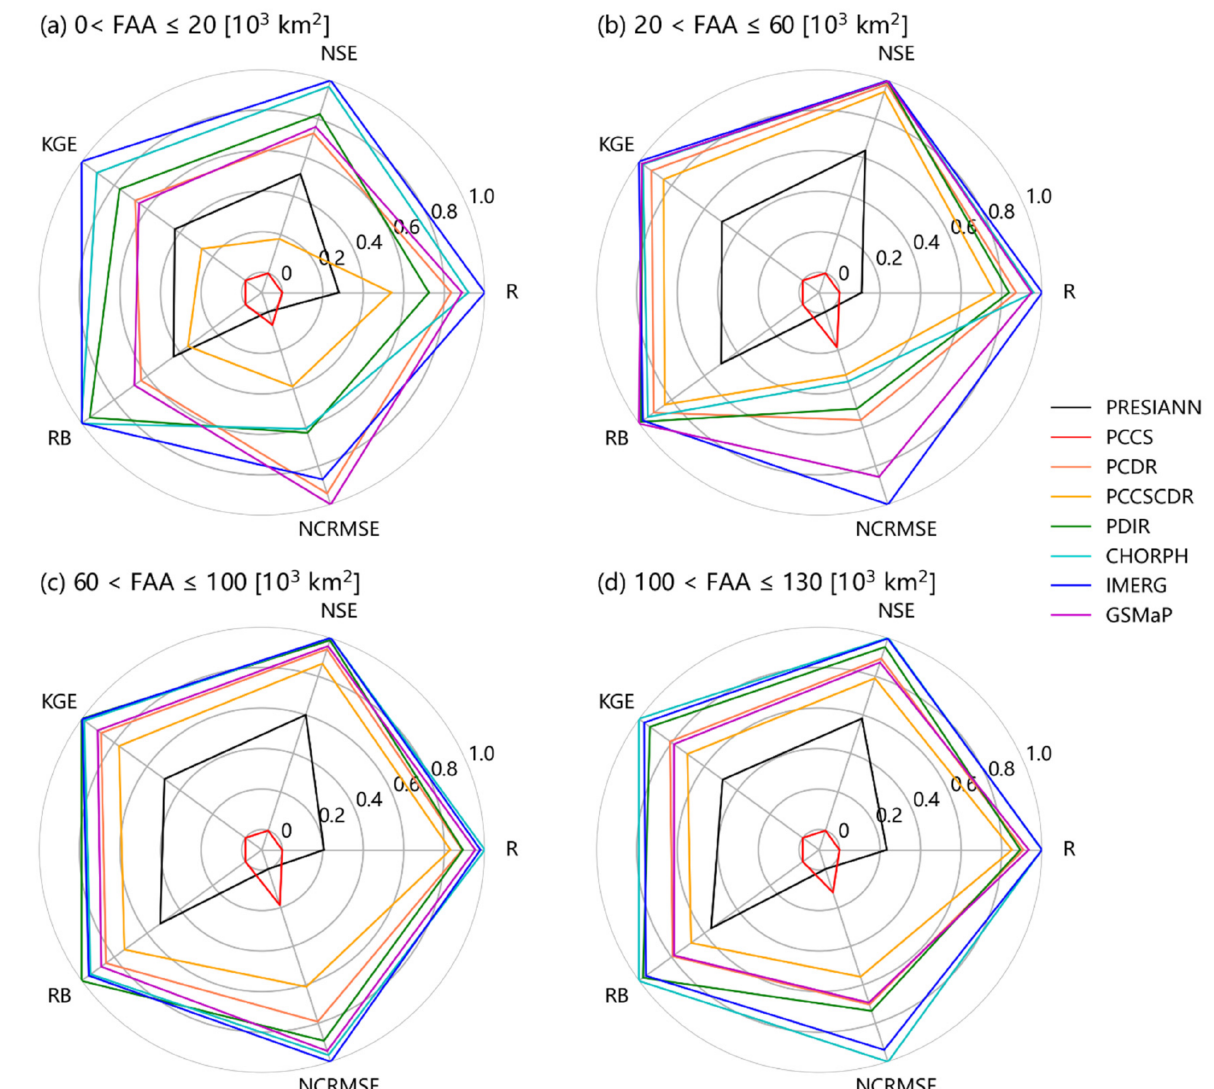
Figure 8. The relative goodness of different products in different catchment area intervals ( a – d ). Pearson correlation coefficient (R); Nash–Sutcliffe efficiency (NSE); Kling–Gupta efficiency (KGE); Relative bias (RB); Normalized centered root mean square error (NCRMSE). The values shown in the figure are the median of each